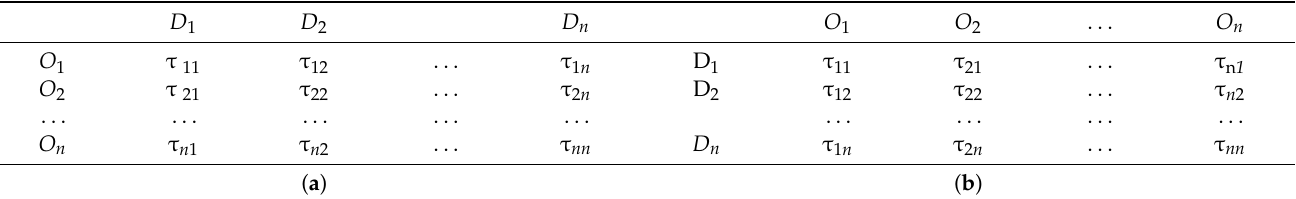
Table 1. Organisation of the data for the agricultural transport cost matrix: ( a ) Destination-based flows; ( b ) Origin-based